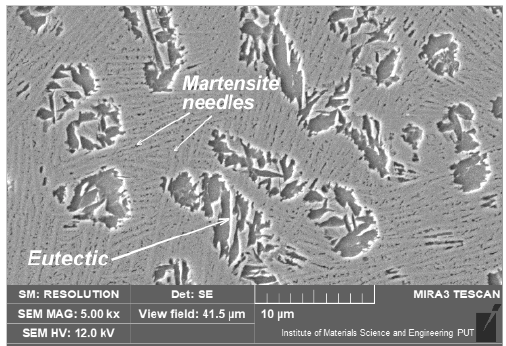
Figure 11. Examples of the AES and EDS spectra of the zones alloyed with: Si ( a ), Co ( b ), Si 3 N 4 ( c ) and Ti ( d ).